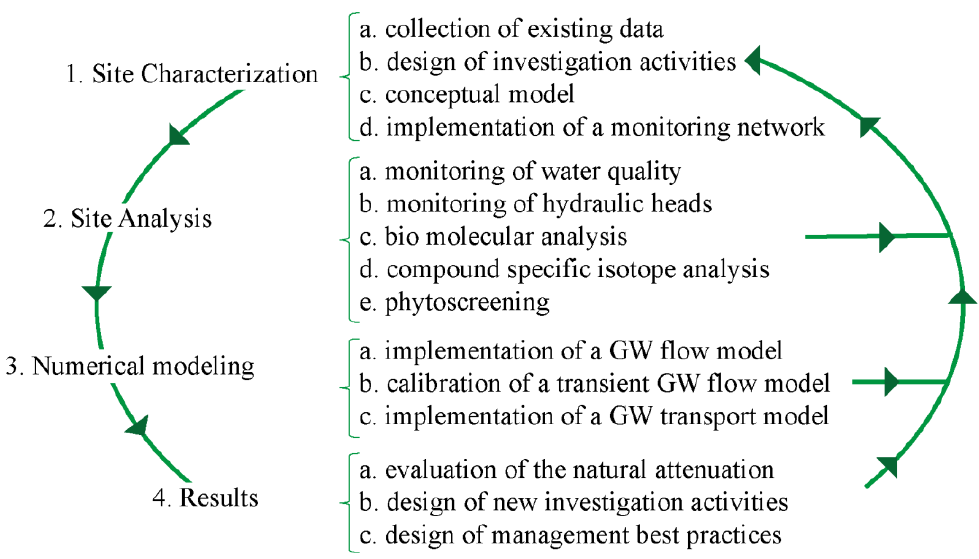
Figure 1. Approach. Multi step circular approach applied in the present work. GW means ground- water.